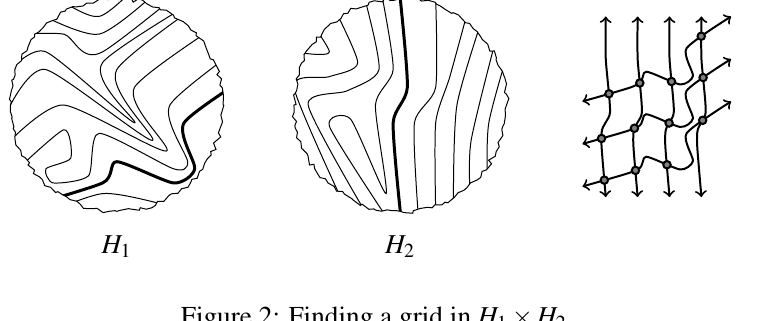
Figure 2: Finding a grid in H 1 × H